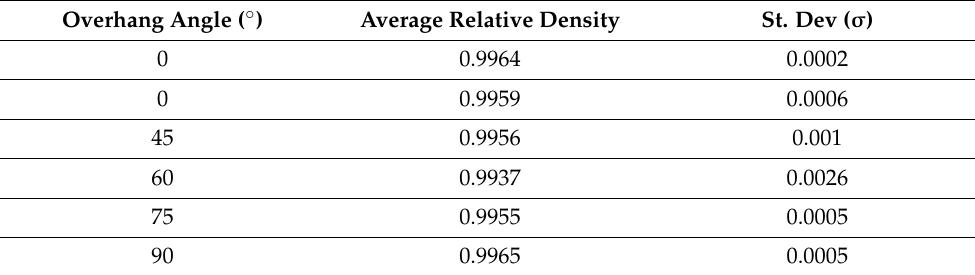
Table 2. Relative density of the produced L-PBF parts.